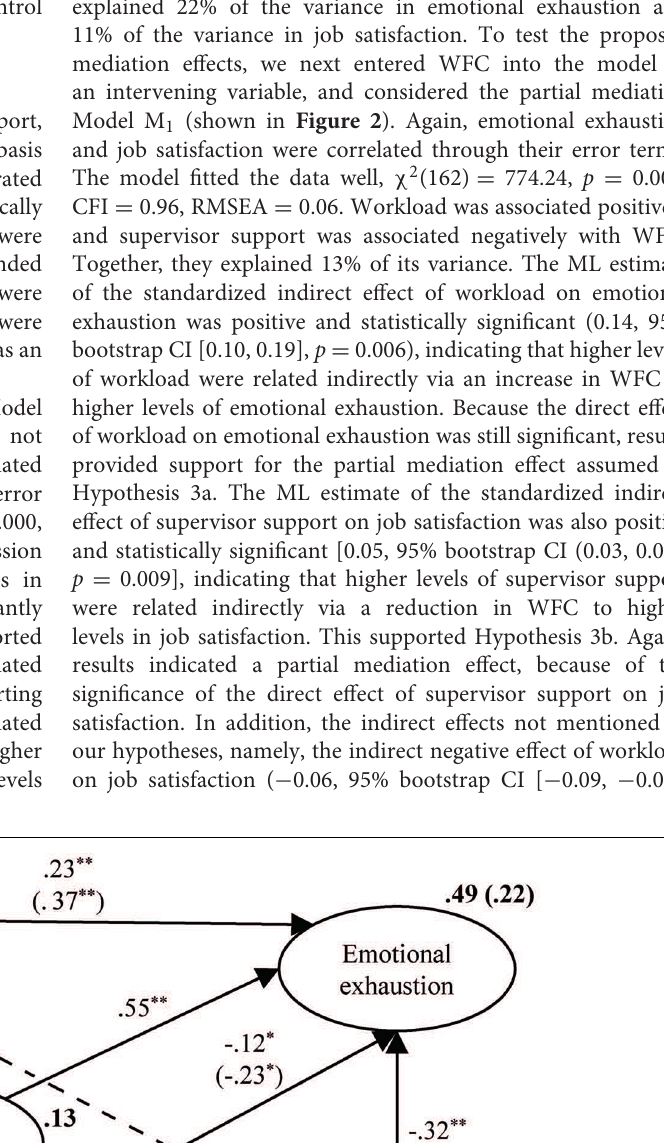
Frontiers in Psychology |